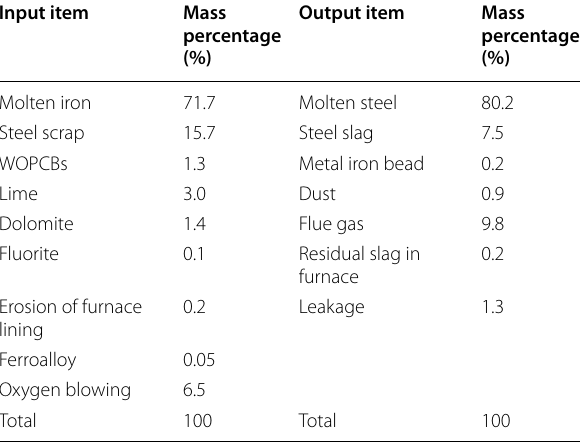
Table 5 Mass balance of the